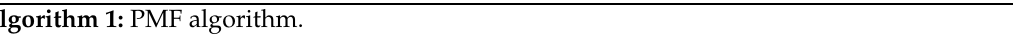
Algorithm 1 summarizes PMF. The inputs are the rating matrix R , the number of latent factors K , and the hyper-parameters to control the learning process λ and γ . The outputs are the latent factors matrices P and Q learned from the rating